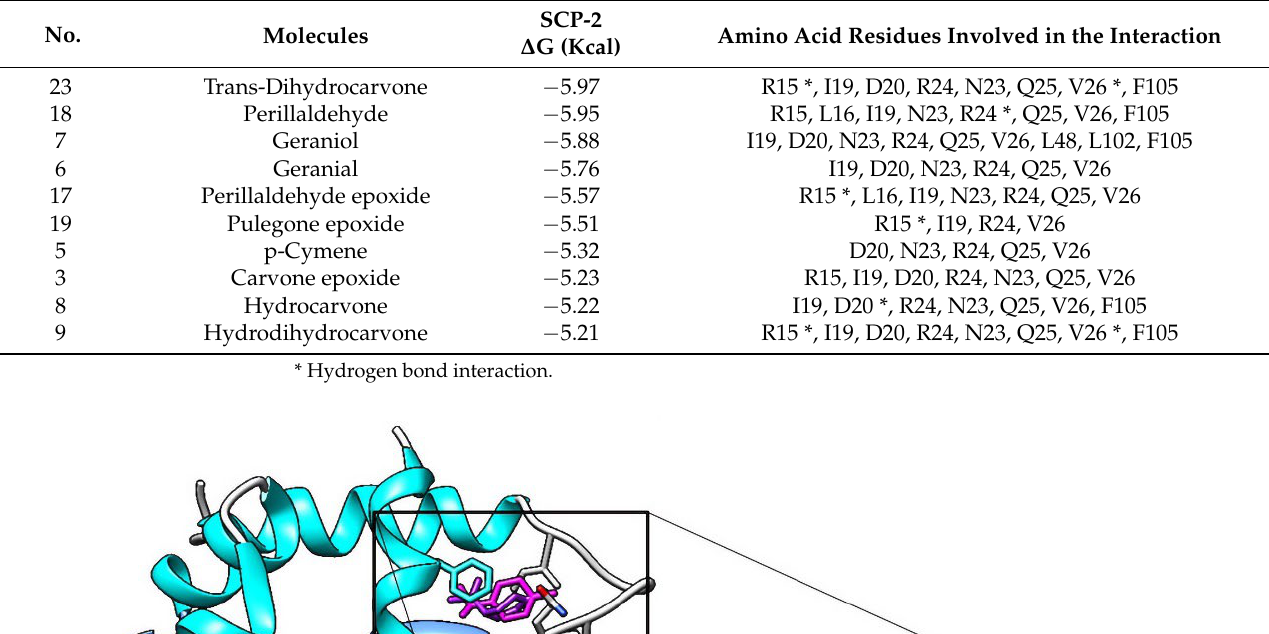
Figure 6. Visualization of SCP-2–ligand interactions: ( a ) carvacrol, ( b ) thymol, ( c ) limonene and ( d ) γ -terpinene.